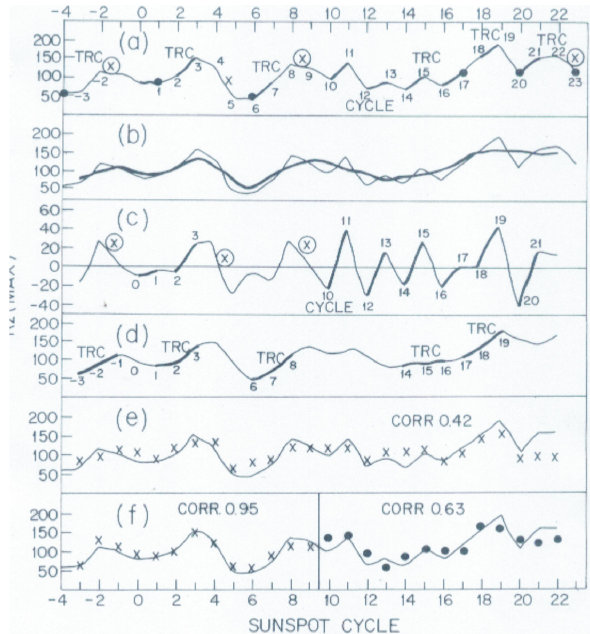
Fig. 3. (a) Plot of Rz (max) for cycles − 4 to 23. The even-odd pairs which obeyed the G-O rule are marked by thick lines and those dis- obeying the G-O rule are marked by circled crosses. The 3-cycle Figure 3. (a) Plot of Rz (max) for cycles –4 to 23. The even-odd pairs which obeyed the2 sequences TRC are labeled, their starting points indicated by big G-O rule are marked by thick lines and those disobeying the G-O rule are marked by3 dots, (b) Plot of Rz (max) series (thin line) and the running mean circled crosses. The 3-cycle sequences TRC are labeled, their starting points indicated4 over three consecutive cycles (long-term trend, superposed thick by big dots, (b) Plot of Rz (max) series (thin line) and the running mean over three5 line), (c) Residues when the 3-cycle running mean is subtracted consecutive cycles (long-term trend, superposed thick line), (c) Residues when the 3-6 from the Rz (max) series. Thick lines and crosses indicate even- cycle running mean is subtracted from the Rz (max) series. Thick lines and crosses7 odd pairs obeying and disobeying G-O rule, (d) 2-cycle running indicate even-odd pairs obeying and disobeying G-O rule, (d) 2-cycle running means,8 means, bringing out the TRC sequences prominently, (e) Original bringing out the TRC sequences prominently, (e) Original Rz (max) series (full line) and9 Rz (max) series (full line) and the series reconstructed from spectral components (crosses), (f) original series and the reconstructed se- ries, separately for the first half (crosses) and the second half (big dots).